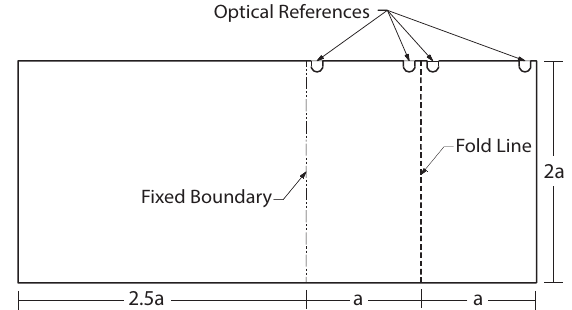
Figure 5. A view of the sample before creasing, with optical mea- surement locators and orientation marks shown. If the material has a rolling direction, the rolling direction would be in the horizontal axis in this